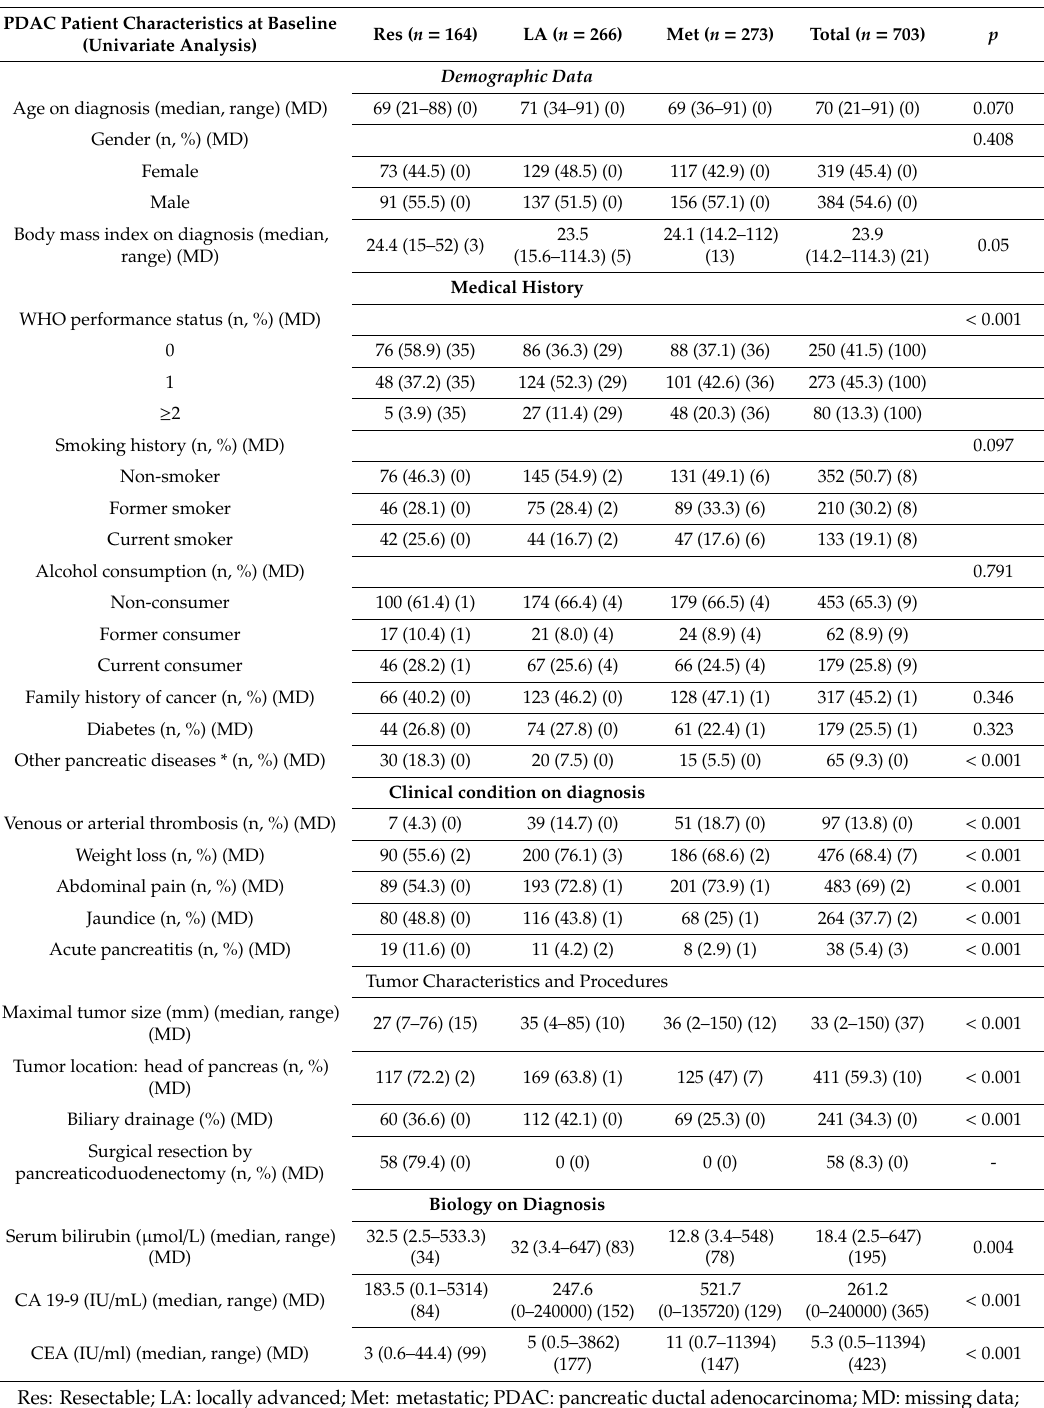
Table 1. PDAC patient characteristics at baseline (univariate